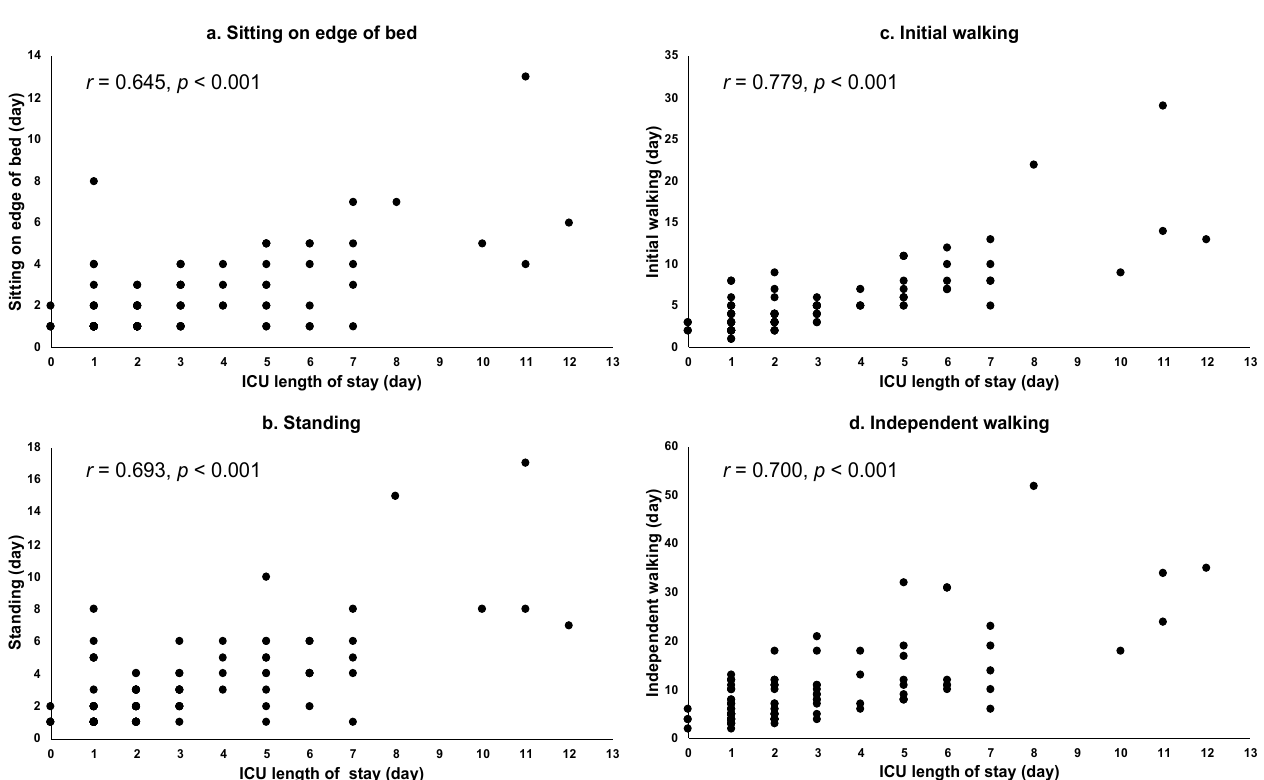
Figure 1. Relationships between ICU length of stay and CR in aortic surgery group. Abbreviation: intensive care unit: ICU. Notes: ( a ) correlation between ICU length of stay and achieving sitting on the edge of a bed, ( b ) correlation between ICU length of stay and achieving standing, ( c ) correlation between ICU length of stay and achieving initial walking, and ( d ) correlation between ICU length of stay and achieving independent walking.